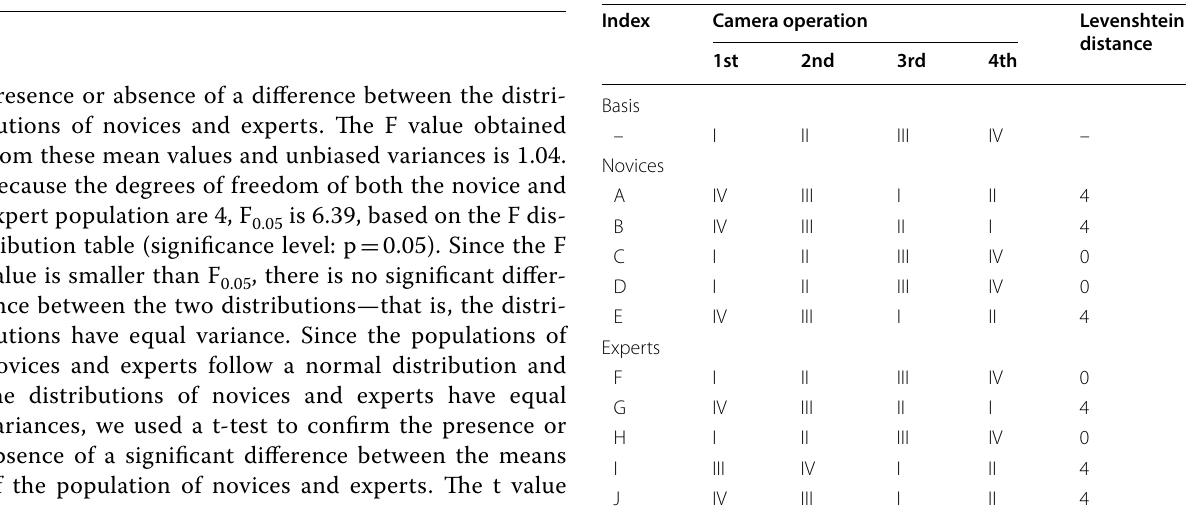
Table 10 Camera operations of novices and